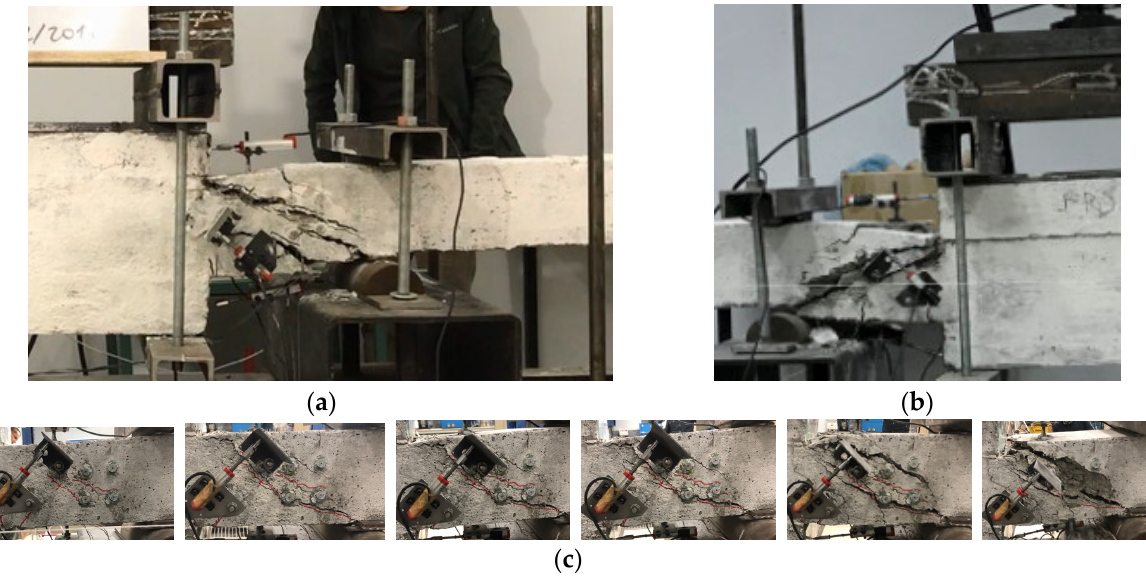
Figure 11. ( a ) First inclined crack in test of DS-O, ( b ) first flexural and inclined crack in test of CCRS- O.